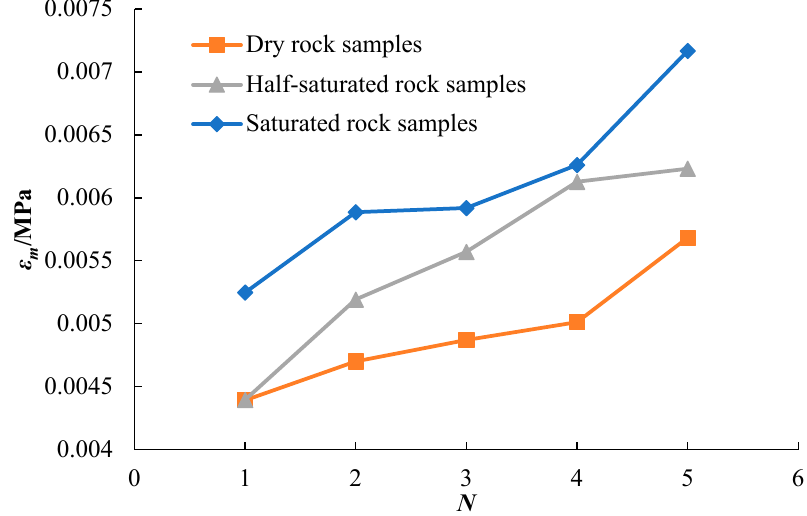
Figure 7. Peak strain variation trend ( 𝜀 (cid:3040) : peak strain). Table 2. Relationship between 𝜎 (cid:3040) , 𝜀 (cid:3040) , and N .